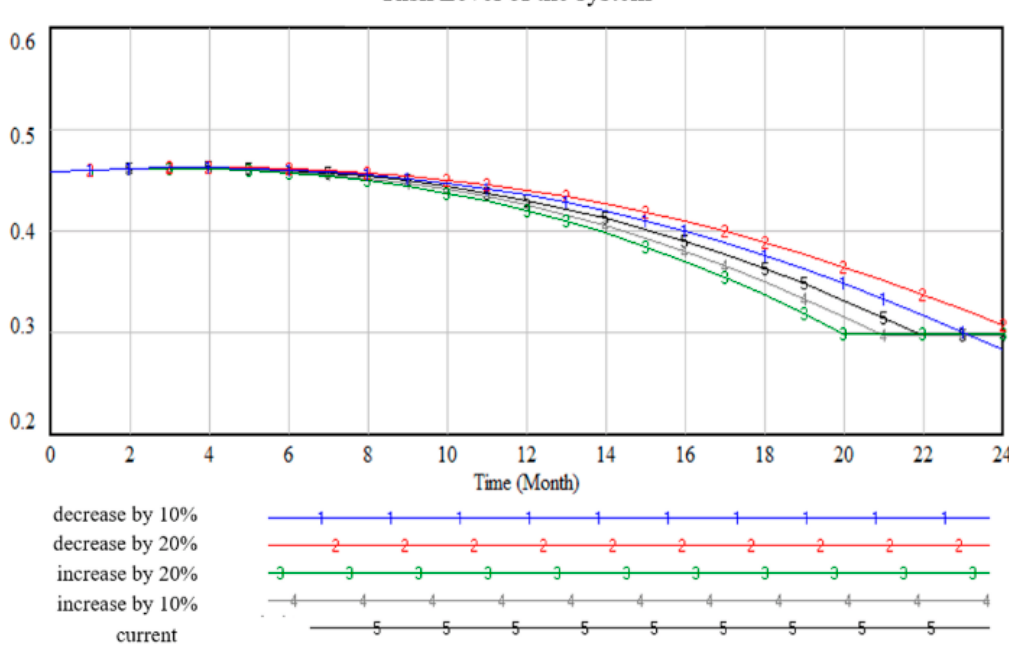
Figure 6. Contrast diagram of risk level under change of safety investment